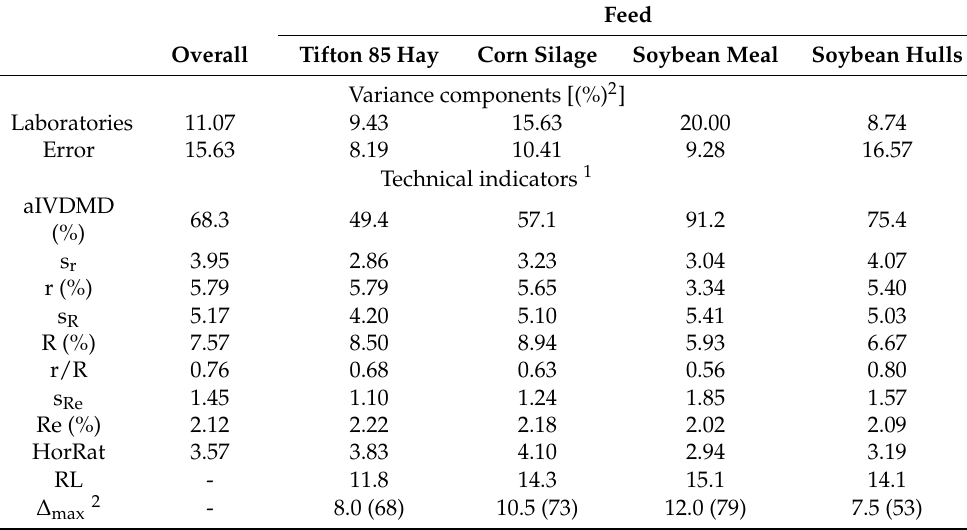
Table 4. Estimates of variance components and technical indicators of the proposed method for in vitro dry matter digestibility, according to the evaluated feed. Feed Overall Tifton 85 Hay Corn Silage Soybean Meal Soybean Hulls Variance components [(%) 2